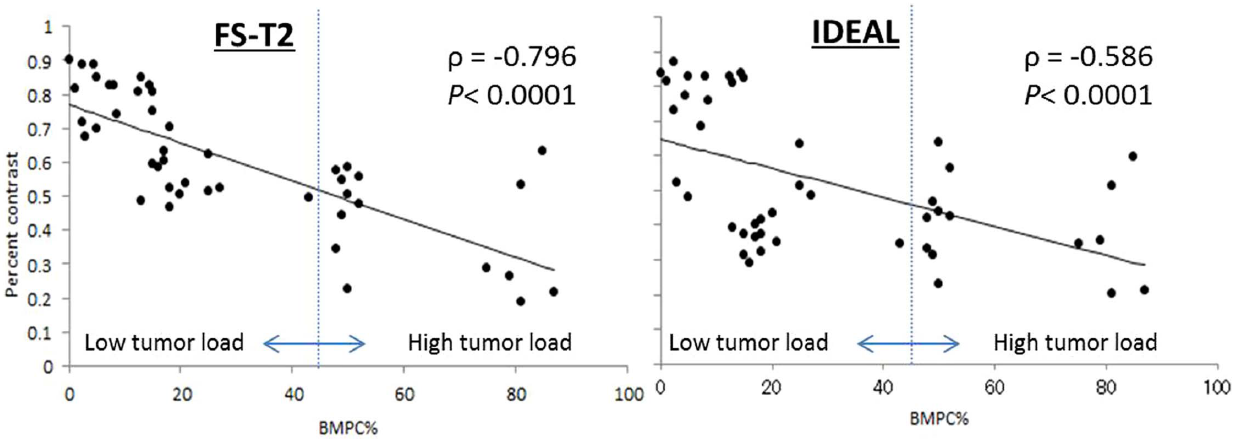
Figure 1. Graph of the BMPC% versus percent contrast. The linear regression curve is shown. Vertical line corresponds to a BMPC% of 45%.